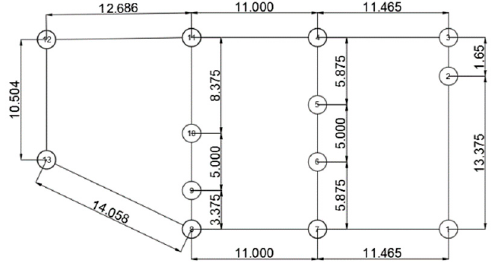
Figure 7. Undirected graph with weights.